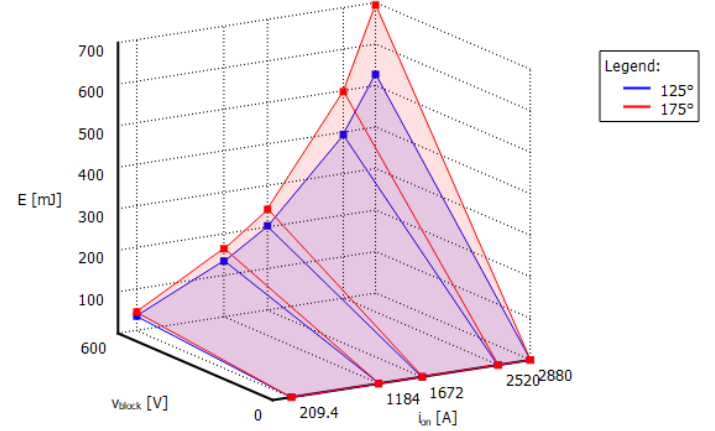
Figure 4. Turn-on losses represented in PLECS thermal library.